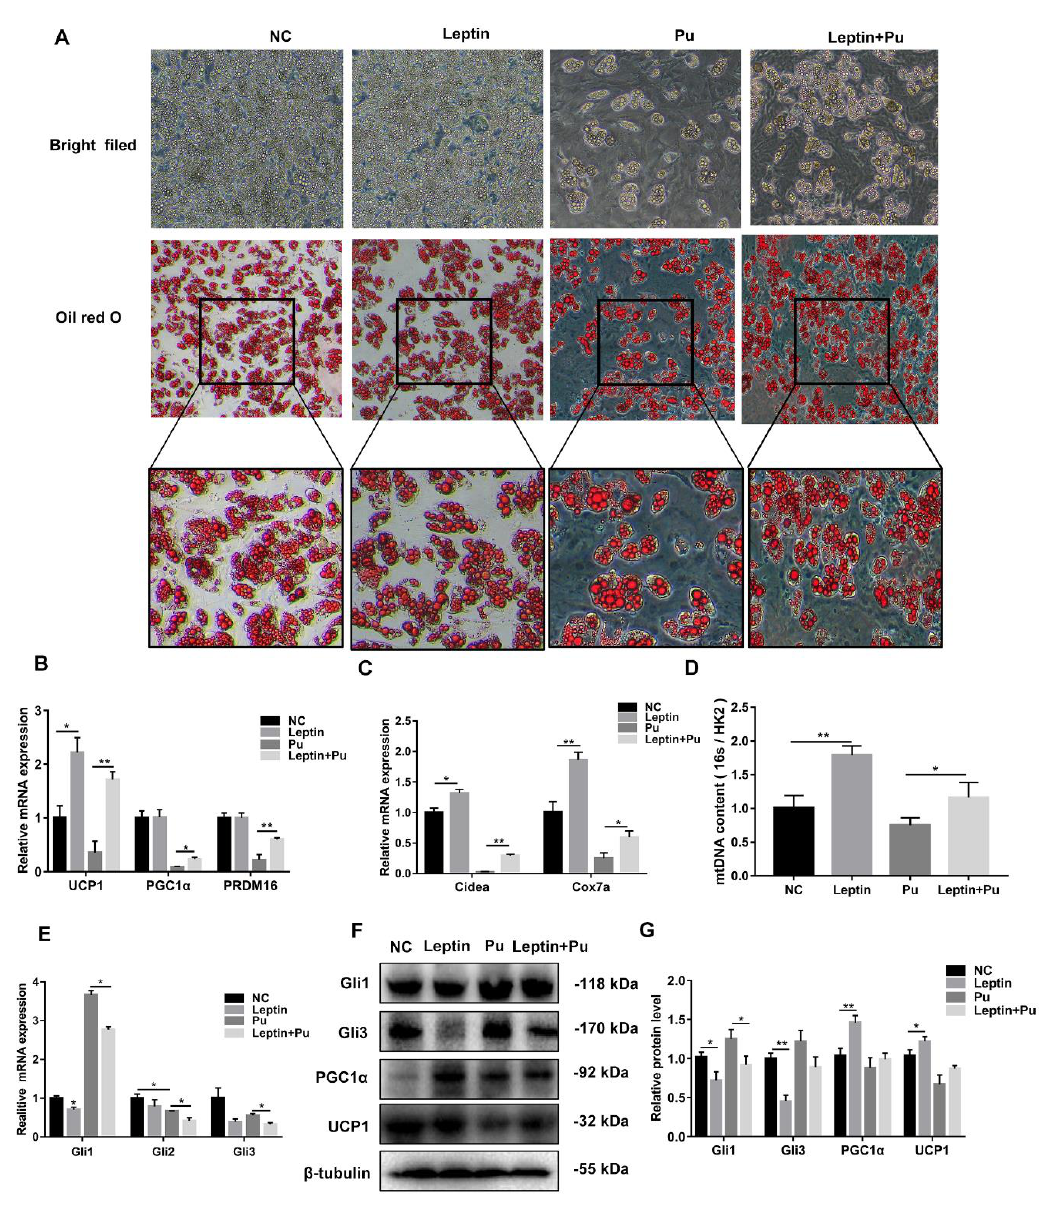
Figure 6. Leptin promotes white adipocyte browning by inhibiting the Hh signaling pathway. ( A ) Oil red O staining. ( B, C, D, E ) RT-qPCR analysis of gene expression related to thermogenic genes, mitochondrial genes, mitochondrial DNA content, and the key transcription factor Glis of the Hh signaling pathway. ( F ) Western blotting analysis of the expression of the key transcription factor Glis of the Hh signaling pathway and browning thermogenic gene expression. ( G ) The resulting quantity protein level. Scale bar = 20 µm, * p < 0.05; ** p < 0.01.